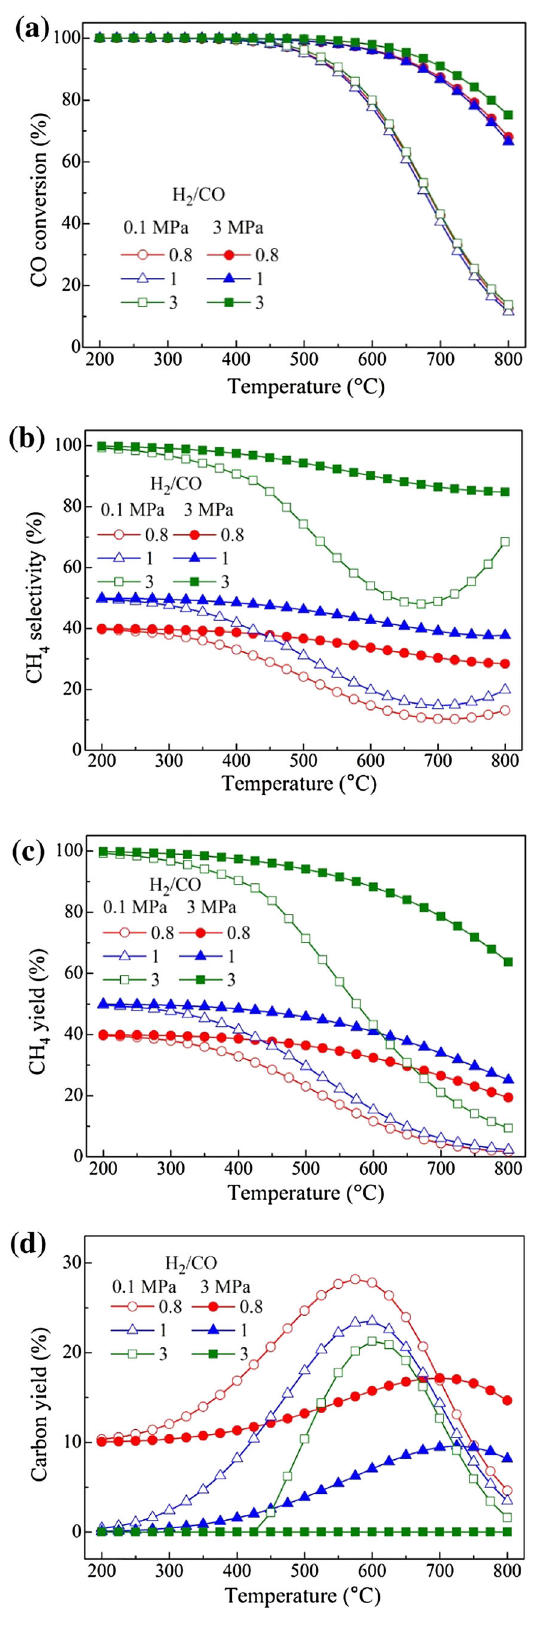
c Fig. 4 Effect of H